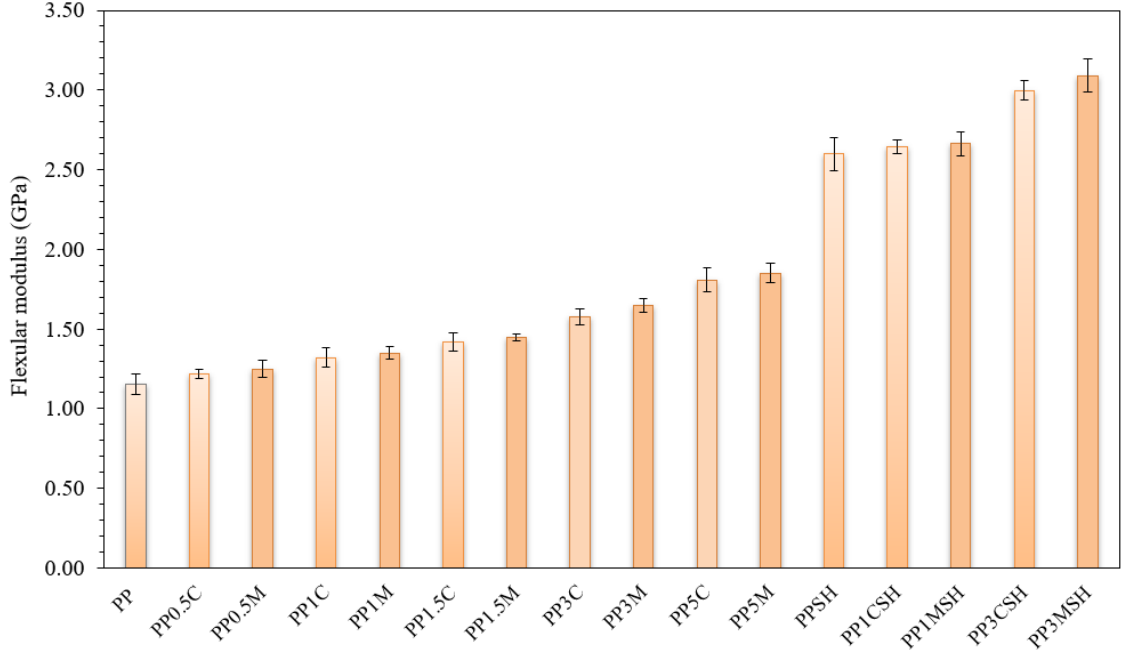
Figure 6. Flexural modulus of PP composites compared to neat PP; darker bars are related to the masterbatch-containing systems.